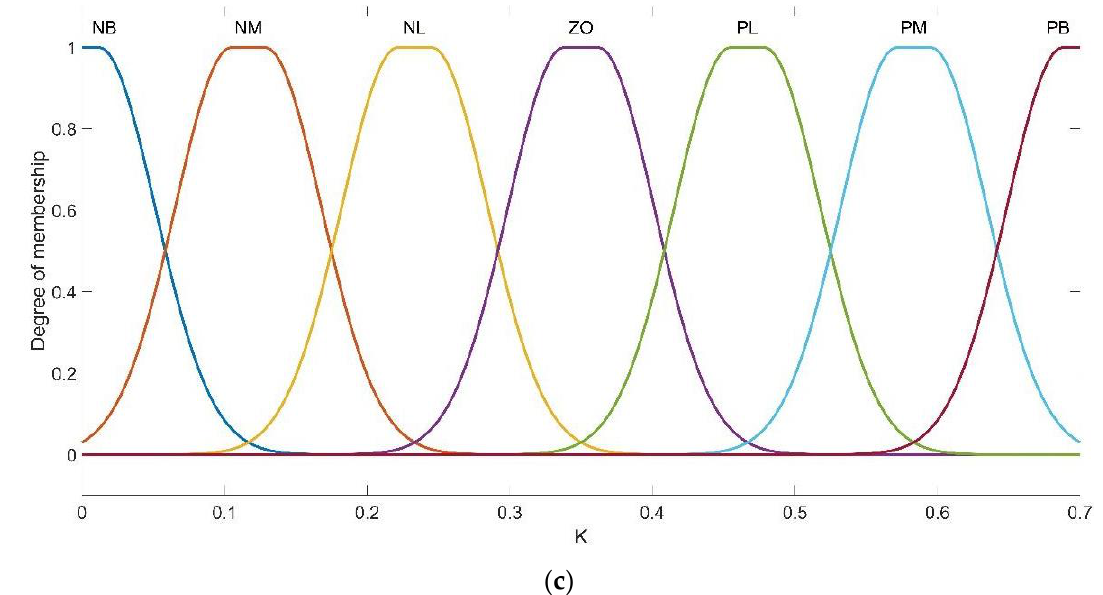
Figure 8. Membership function of the fuzzy system for ( a ) Degree of membership and S (Define in Equation (9)), ( b ) Degree of membership Rate of Consumed Energy, and ( c ) Degree of membership Pump flow rate (K).